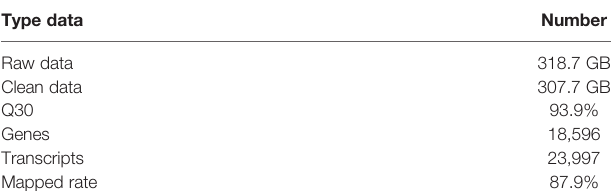
TABLE 3 | Statistics of RNA-Seq sequencing data of the gonad at the early